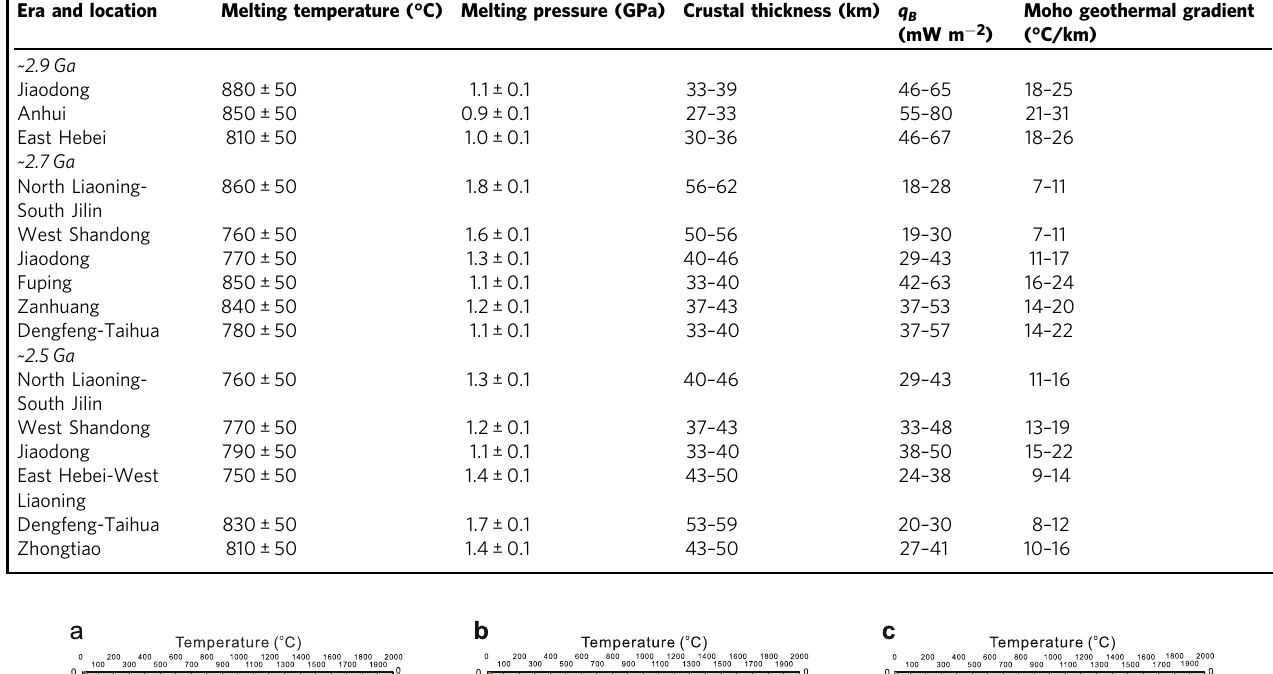
Table 1 Key values of calculated Meso- to Neoarchean thermal state of the Eastern Block, North China Craton. Era and location